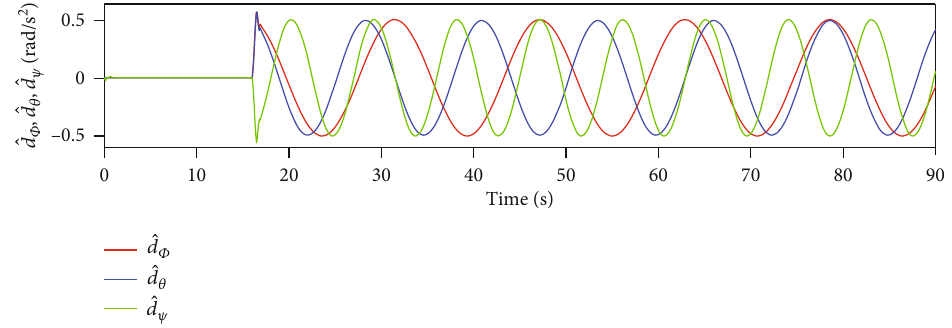
Figure 16: Estimated lumped disturbances for the rotational subsystem by the FTO Table 3: ISE performance index analysis: fl ight scenario 1. Control strategy